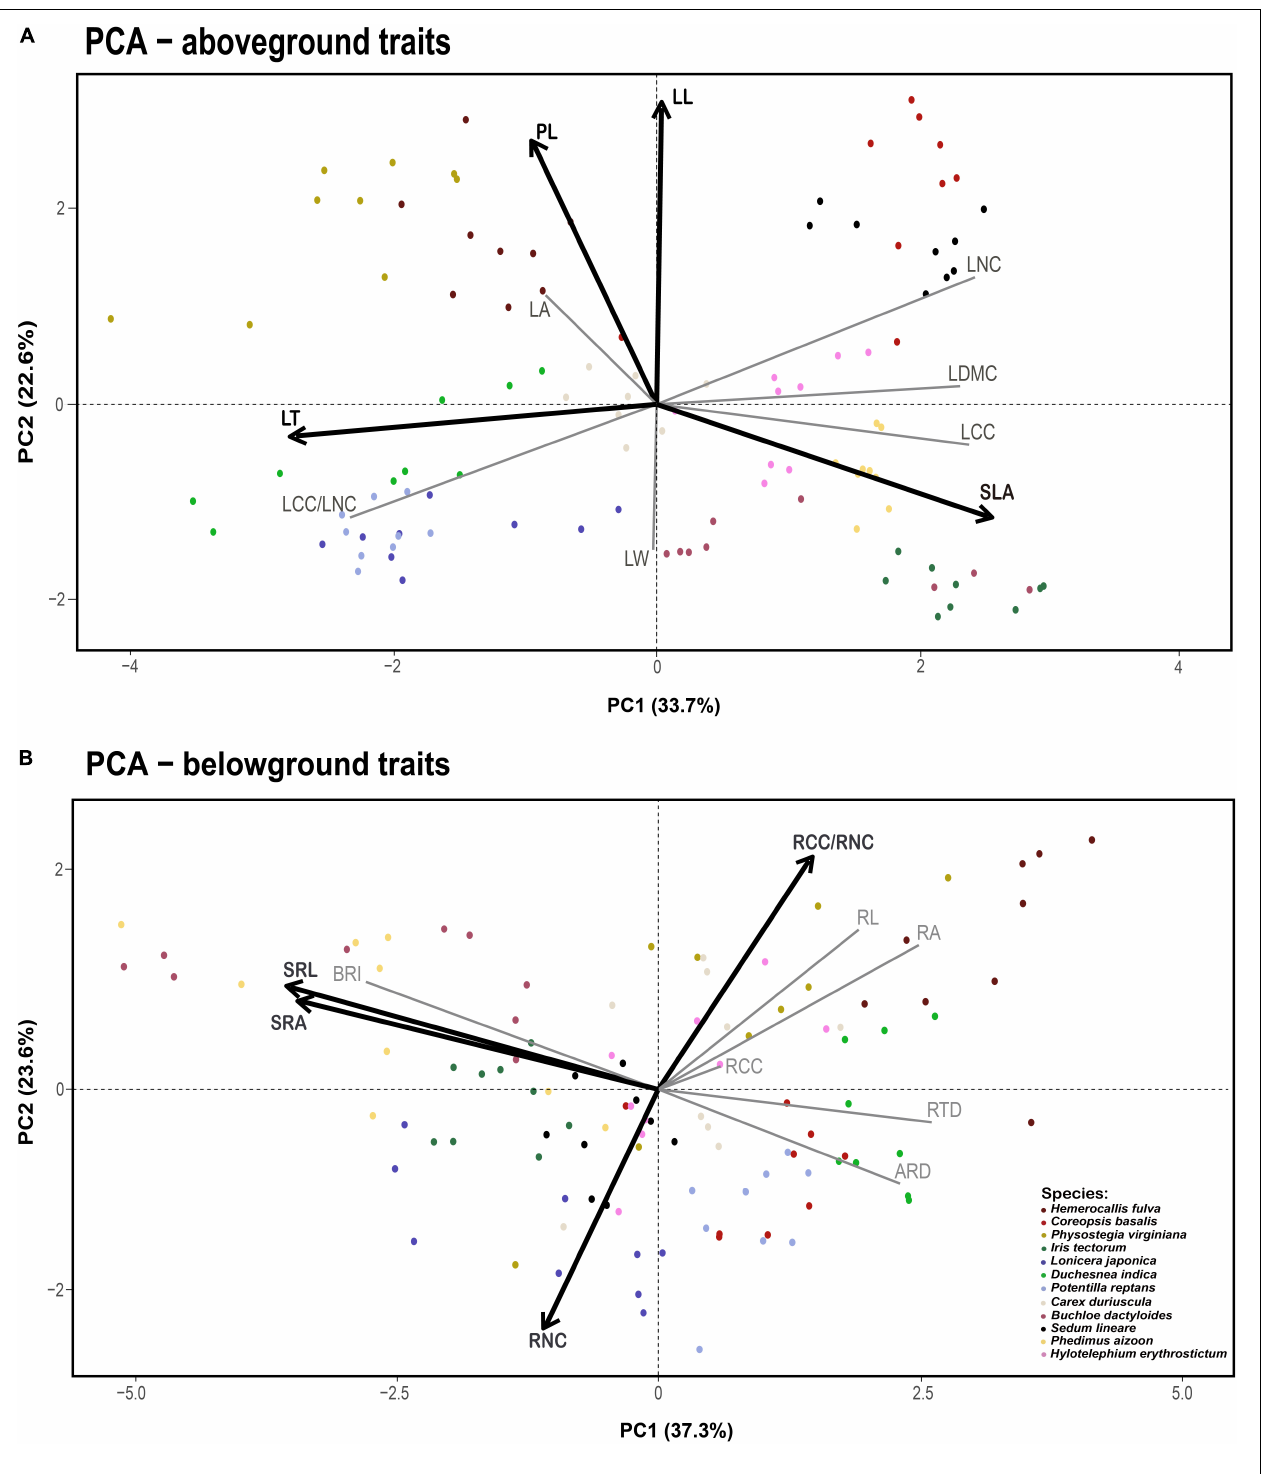
FIGURE 1 | Principal component analysis for aboveground (A) and belowground traits (B) . Vectors represent the relative contribution of each plant trait to the axis. The two variables that load most strongly on each axis are shown in dark black lines, with the remaining variables shown in light gray. Dots of different colors denote the different species samples. Trait acronyms: LA = leaf area, SLA = specific leaf area, LDMC = leaf dry matter content, LL = leaf length, LW = leaf width, LT = leaf thickness, LNC = leaf nitrogen content, LCC = leaf carbon content, LCC/LNC = the ratio between leaf carbon and nitrogen, PL = plant height, SRL = specific root length, RNC = root nitrogen concentration, RCC = root carbon concentration, RCC/RNC = the ratio between root carbon and nitrogen, RTD = root tissue density, RA = root area, SRA = specific root area, BRI = branching intensity, RL = root length, ARD = average root diameter.